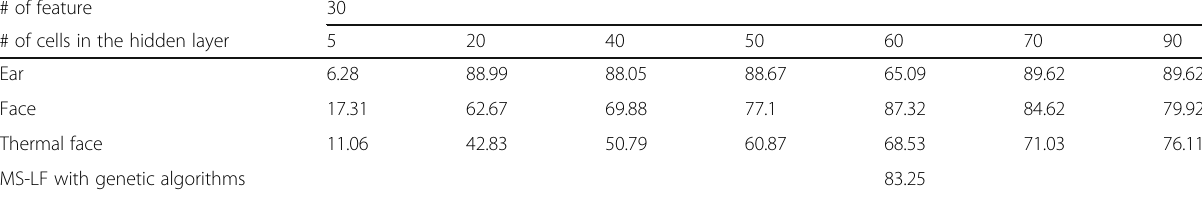
Table 2 Matching score-level fusion with eigenfeatures (#feature 30) # of feature